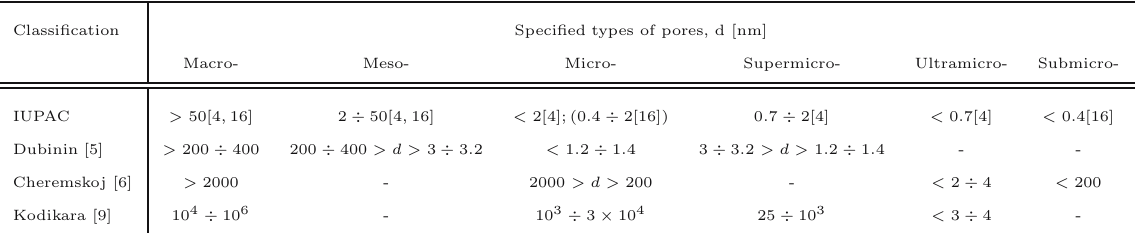
Table 1 Summary of the most frequently used pore size